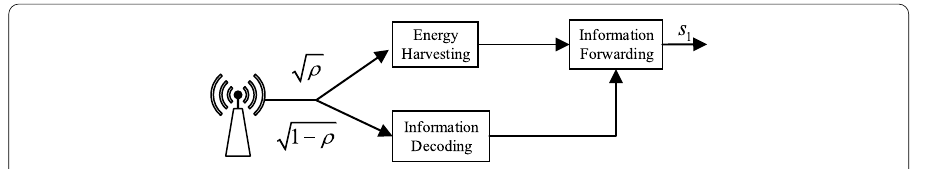
Fig. 2 The power splitting architecture at user